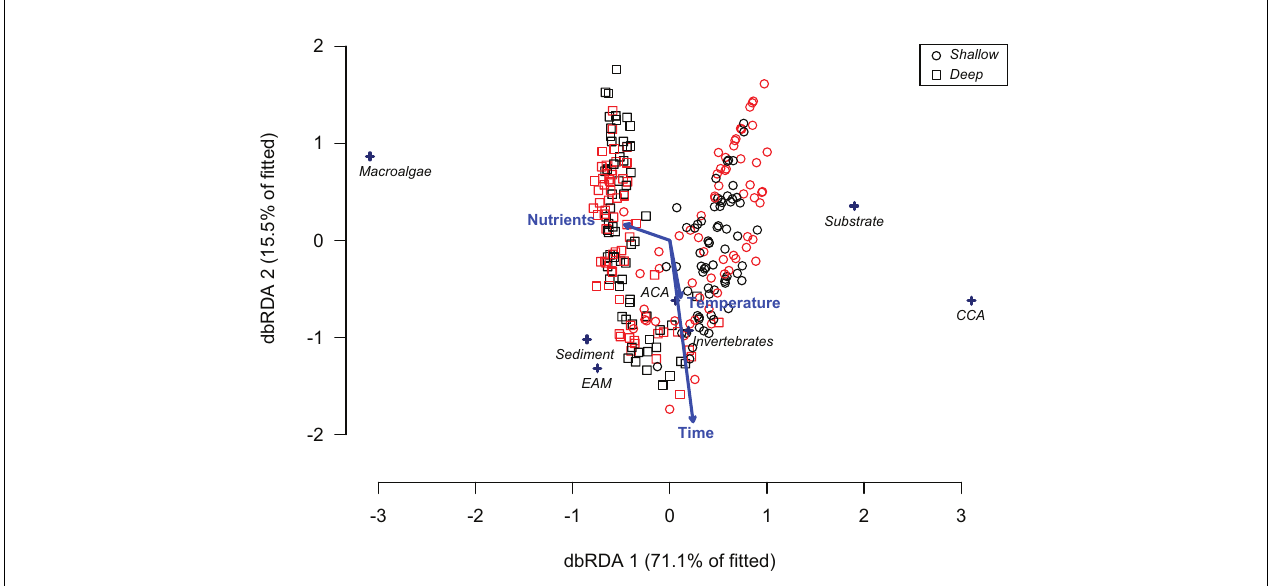
FIGURE 6 | Ordination biplot (distance-based redundancy analysis) of abiotic factors influencing the benthic cover of untouched plots (i.e., controls) in rocky shores from Arraial do Cabo (RJ, Brazil). CCA – crustose coralline algae. ACA – articulated coralline algae. EAM – epilithic algal matrix. The color of symbols indicates site origin, red = Pedra Vermelha and black = Abobrinha. Shallow = 1–2 m, Deep = 5–6